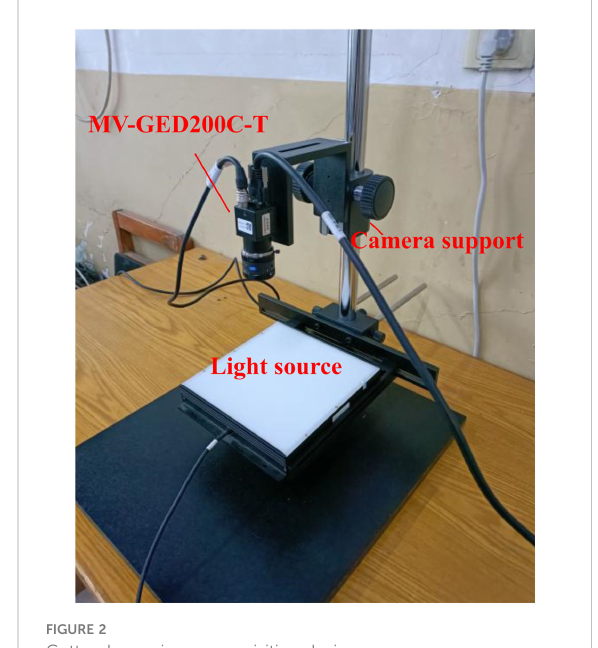
FIGURE 2 Cotton leaves image acquisition